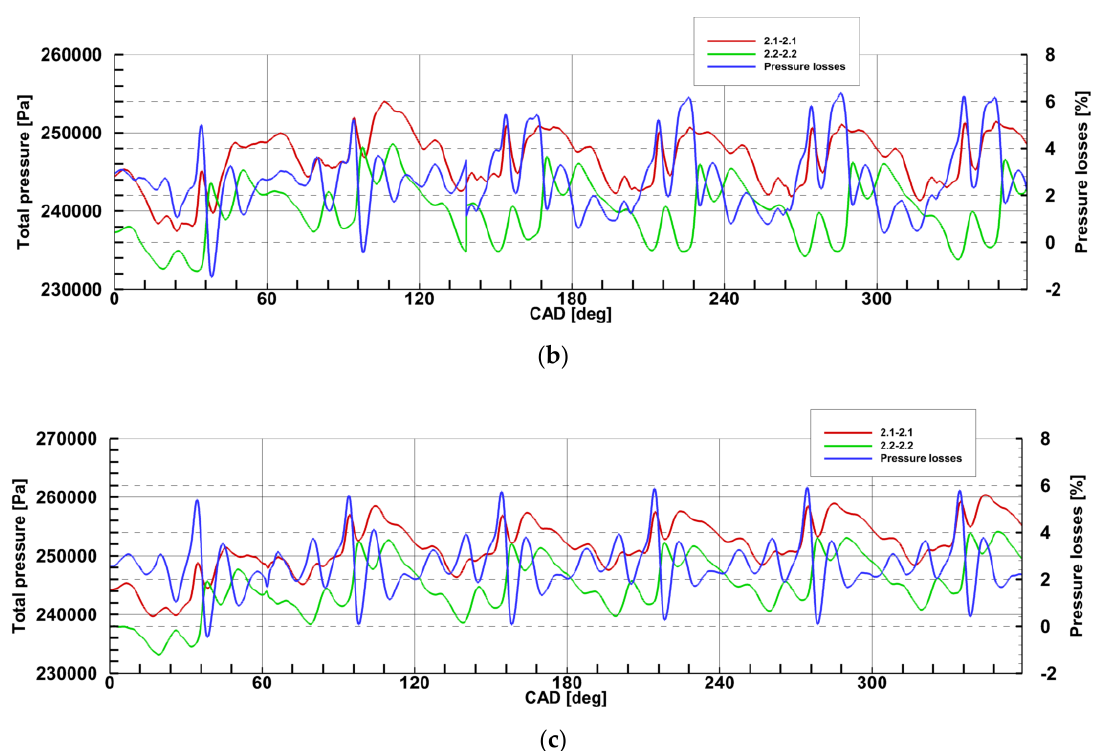
Figure 14. The pressure plots monitored at the Sections 2.1-2.1 and 2.2-2.2 with the percentage pressure losses between both Sections for: ( a ) n = 40,000 rpm; ( b ) n = 50,000 rpm; ( c ) n = 60,000 rpm.